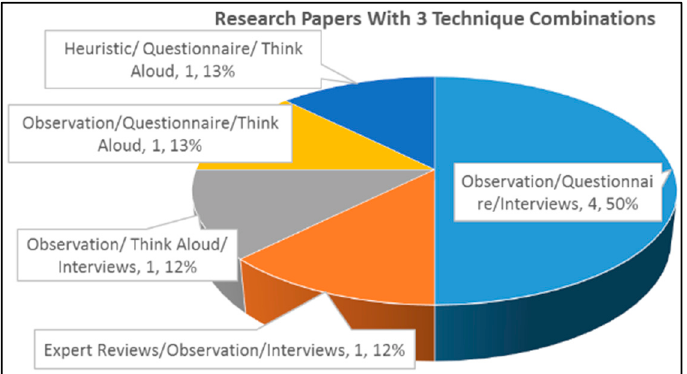
Figure 8. Papers with three technique combination.